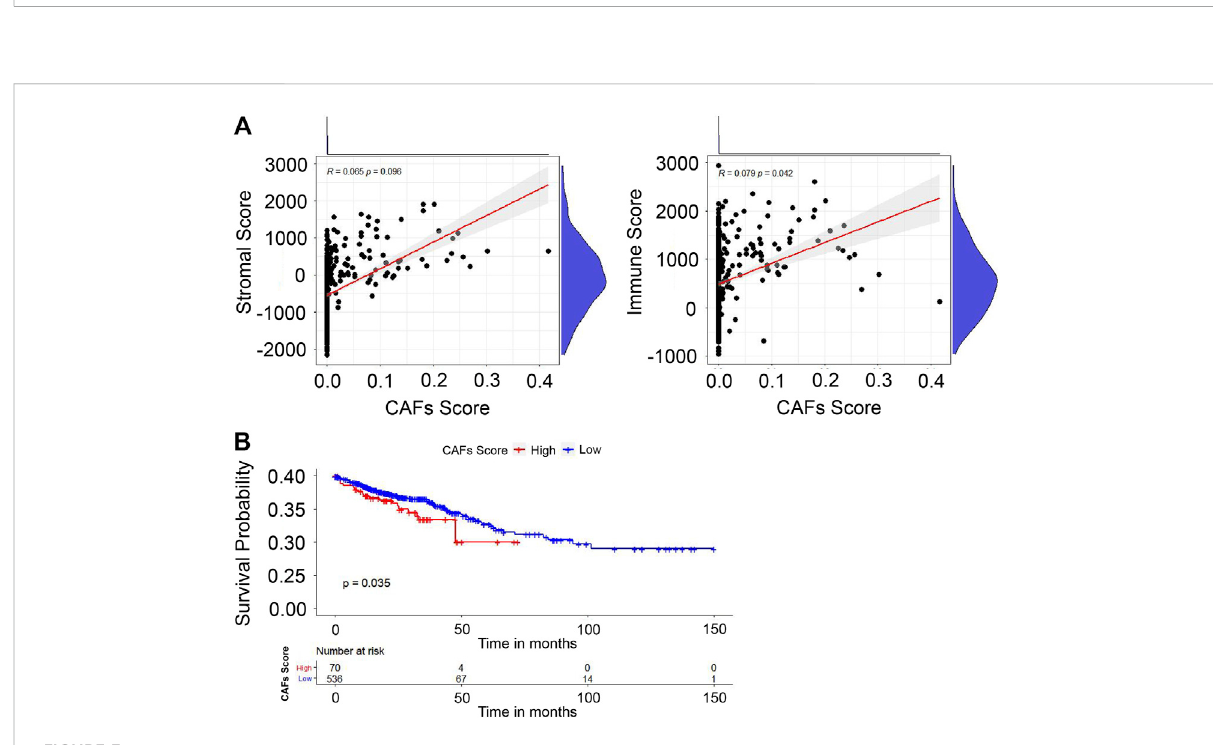
FIGURE 3 Evaluation of stromal/immune scores in CRC tissues. (A) The correlation between the stromal/immune scores and CAFs in fi ltration score. (B) The correlation between CAFs in fi ltration score and